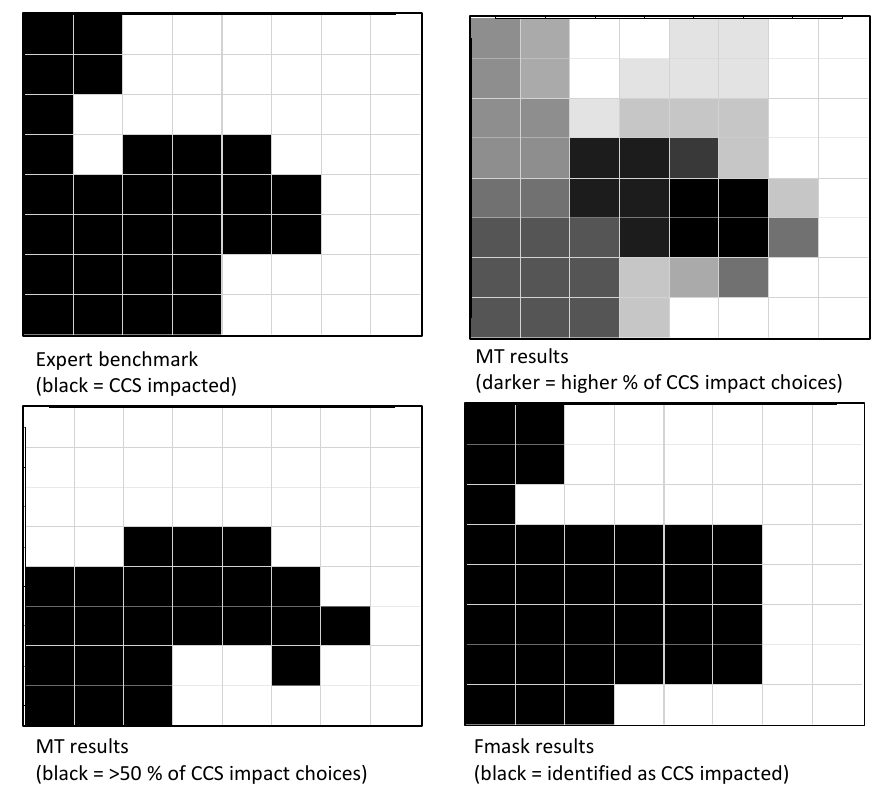
Figure 5. Results for DIFFICULT